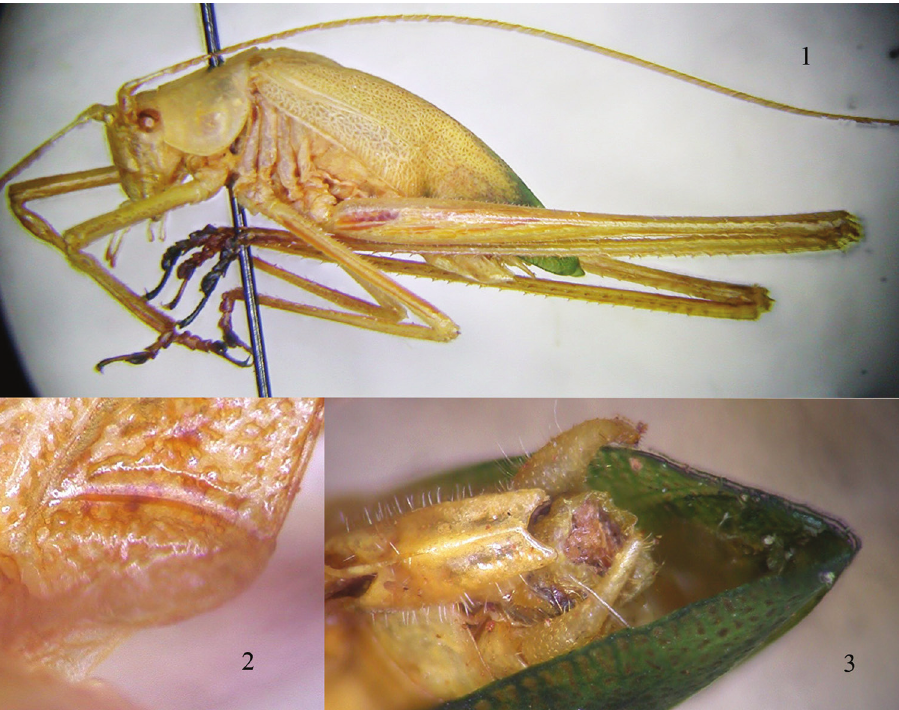
3 subgenital plate and cerci of male.